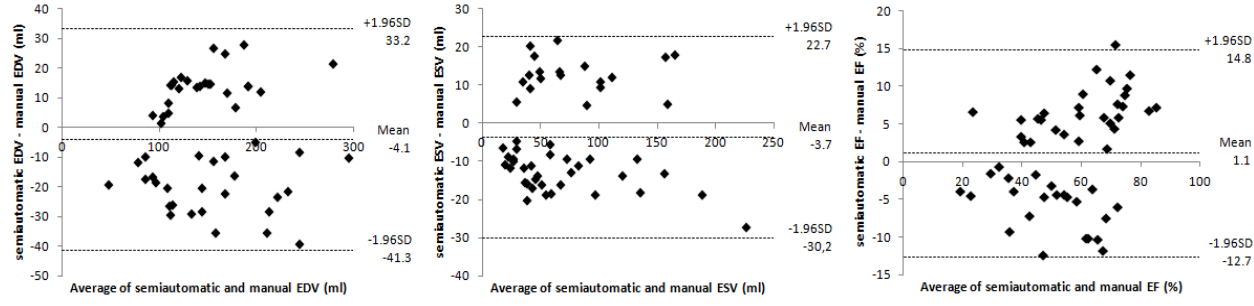
Figure 3. From left to right: Bland-Altman plots show the agreement between semiautomatic and manual segmentation methods, for left ventricular end-diastolic volume (EDV), end-systolic volume (ESV), and ejection fraction (EF).